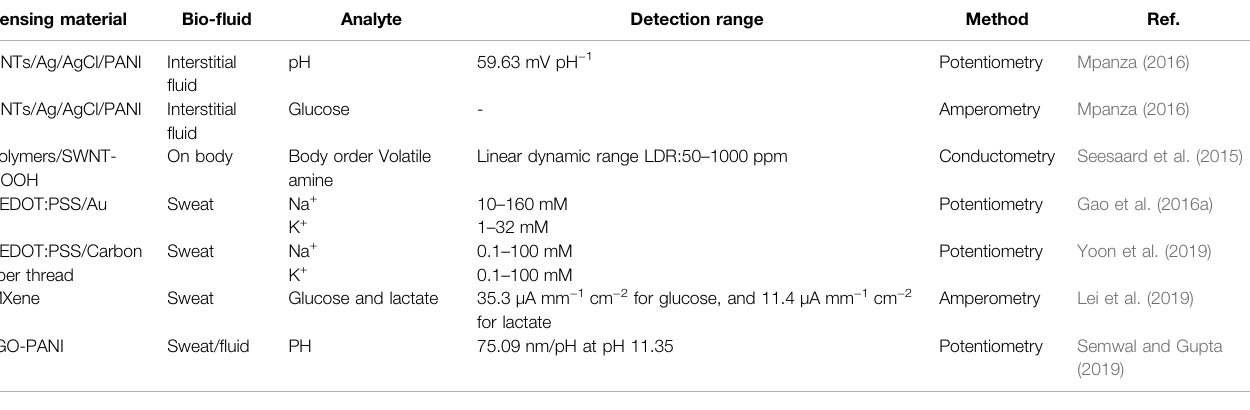
TABLE 5 | Other conducting nanomaterials in electrochemical biosensors.